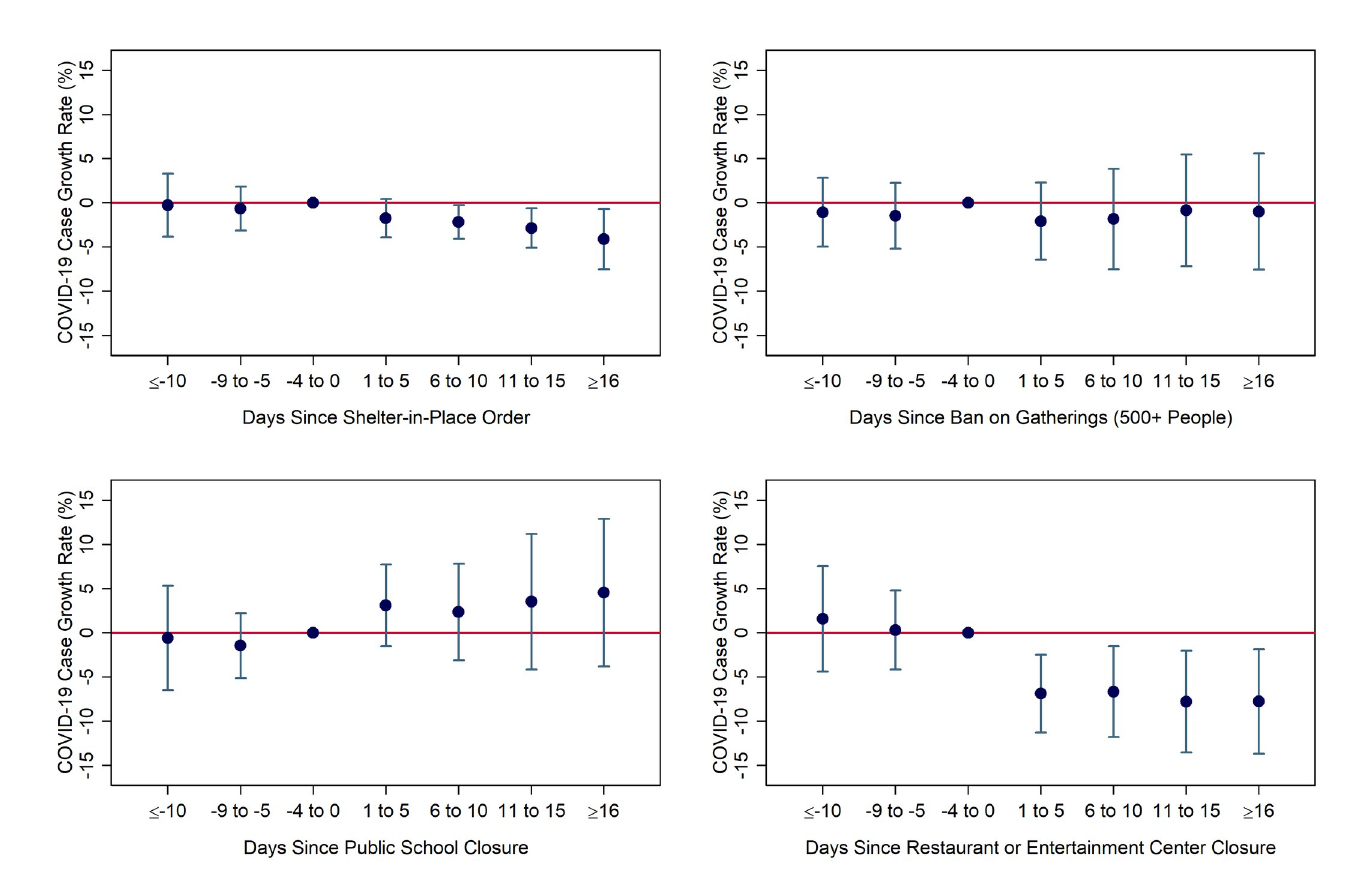
Fig 3. Coefficient estimates for uninteracted social-distancing measures over time from model including index. Notes: Coefficients and 95% confidence intervals were derived from authors’ event-study regression using daily county-level data from March 5-April 25 from the South and Midwest Census Regions, weighted by population. Day and county fixed effects were included. Standard errors were heteroskedasticity-robust and clustered by state. Specifications include interactions between regulation indicators and the “white working class” index variable.